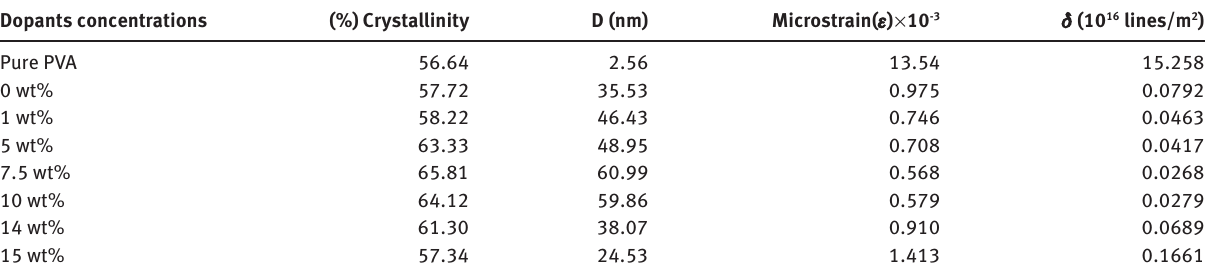
Table 1: Structural parameters of the PVA doped with MWCNT’s and ZnO nanoparticles. Dopants concentrations (%)